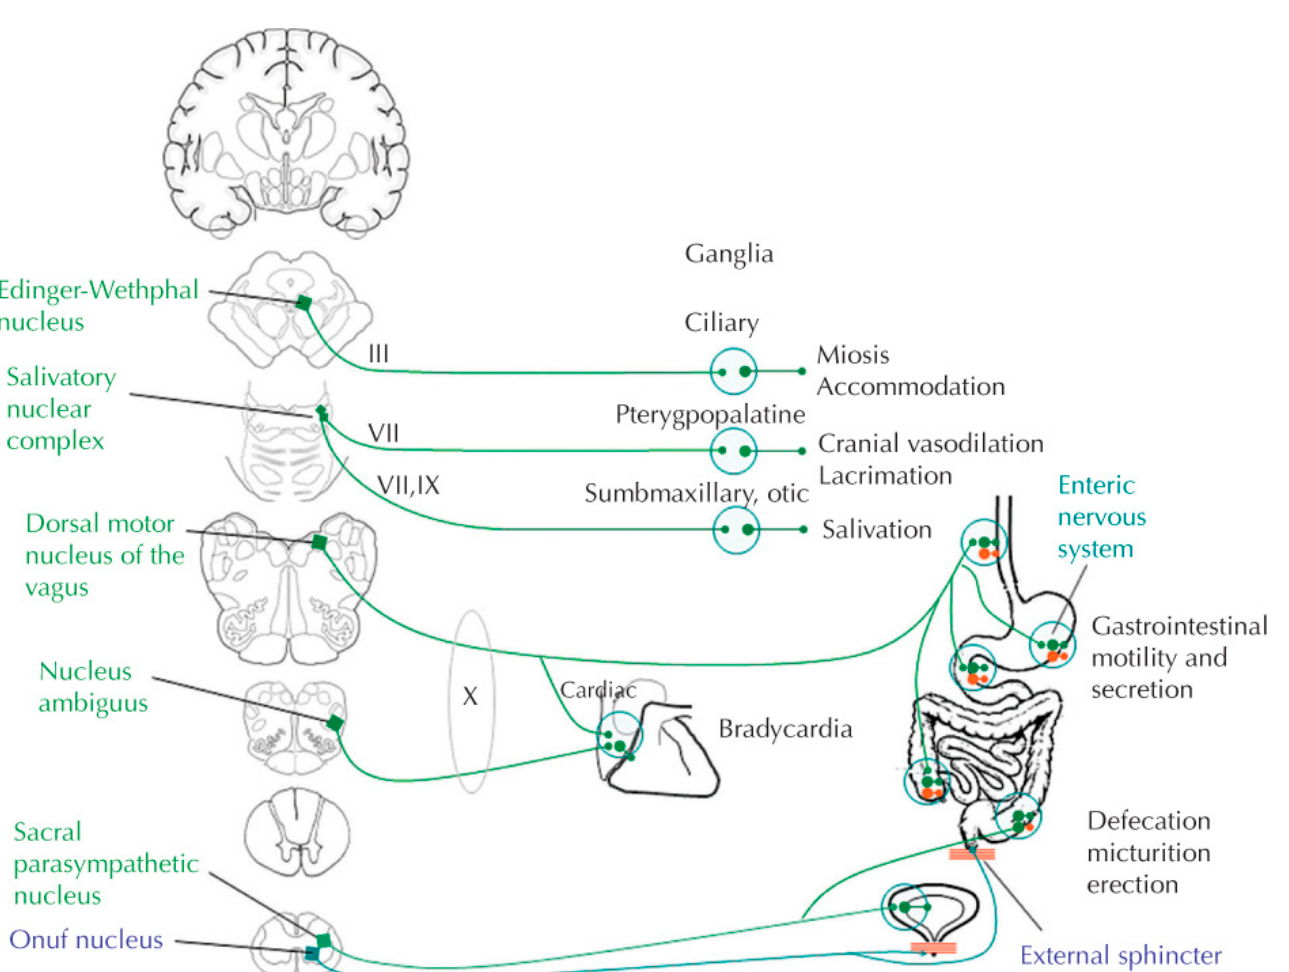
Figure 2. Main effectors and effects of the parasympathetic system. The effects of the parasympathetic system are mediated by neurons located in the vicinity or within the wall of the effector structures. With permission from E.E. Benarroch. Autonomic Neurology. Oxford University Press. NY, NY. © Mayo Foundation for Medical Education and Research 2014.